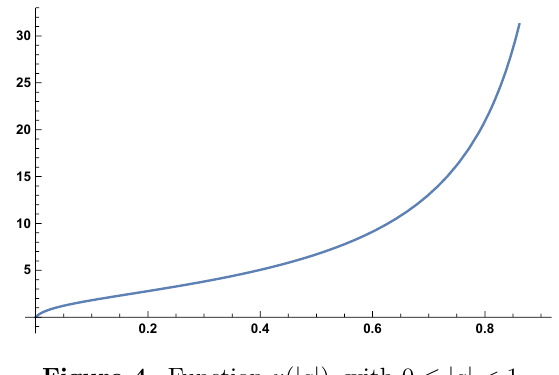
Figure 4. Function v ( j q j ), with 0 (cid:20) j q j <